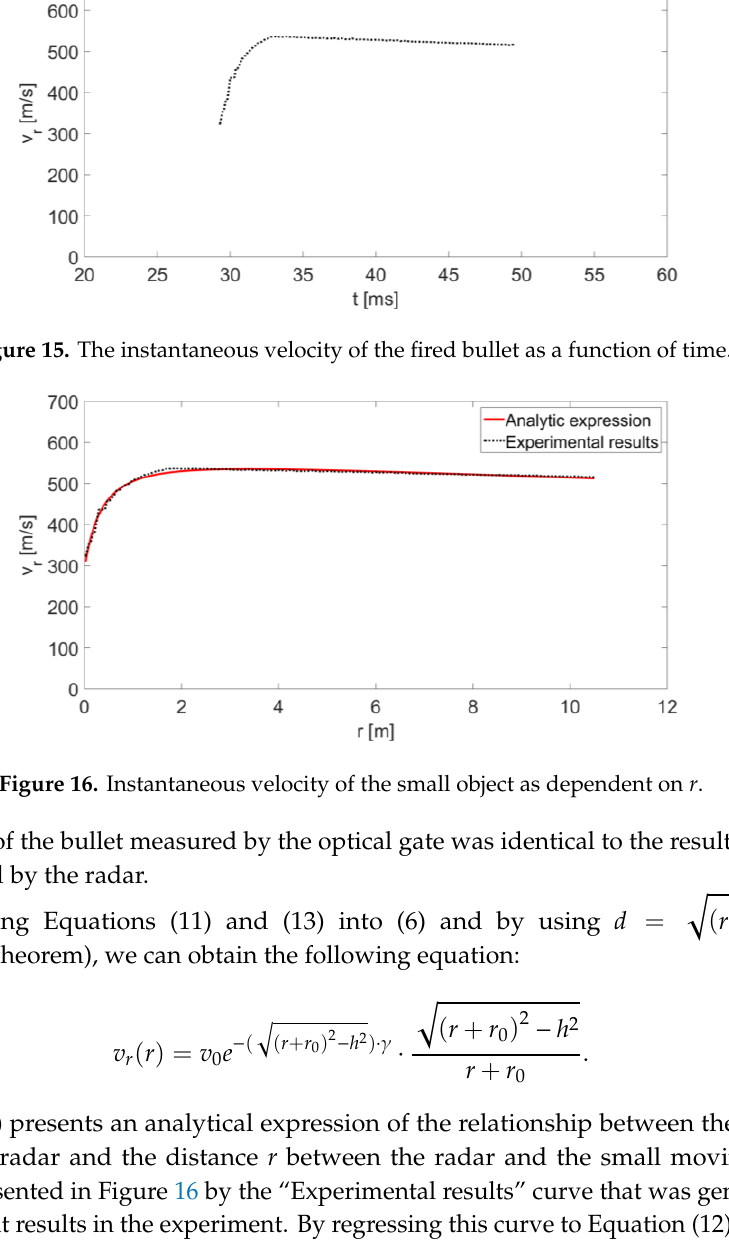
Figure 14. The instantaneous velocity of the fired bullet as a function of time.